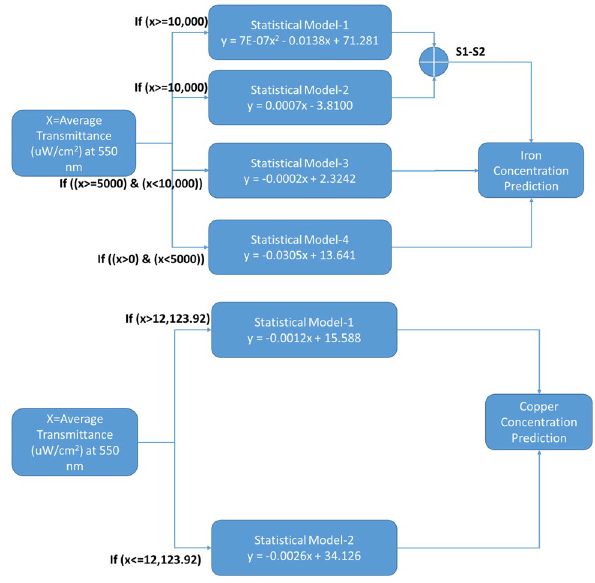
Fig. 8 Designed model for copper and iron concentration prediction in heavy metal concentration